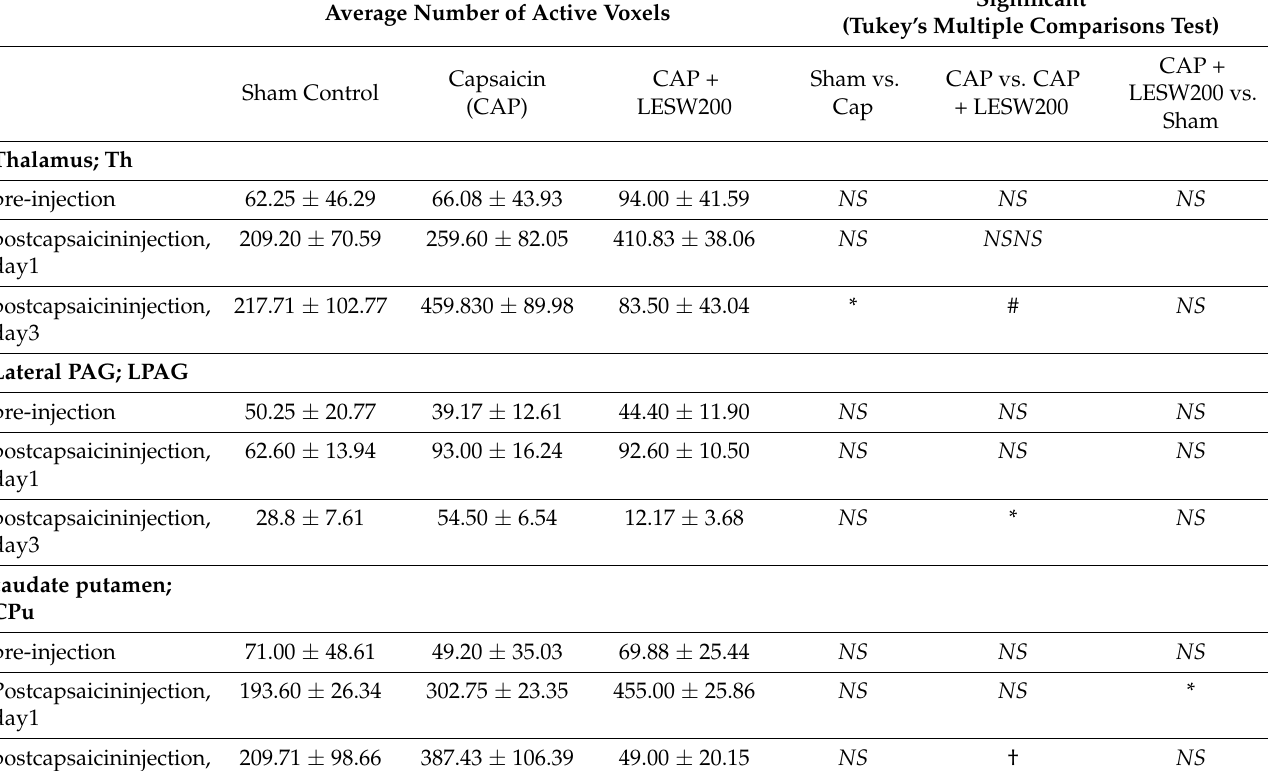
Table 3. Capsaicin intraprostatic injection induced fMRI bold signal changes in brain. Regions of interest including thalamus, lateral periaqueductal grey and caudate putamen of rats. Data presented as the average number of active voxels in ROI. Data shown in means ± SEM. n = 8 per group. * p < 0.05; # p < 0.01; † p <